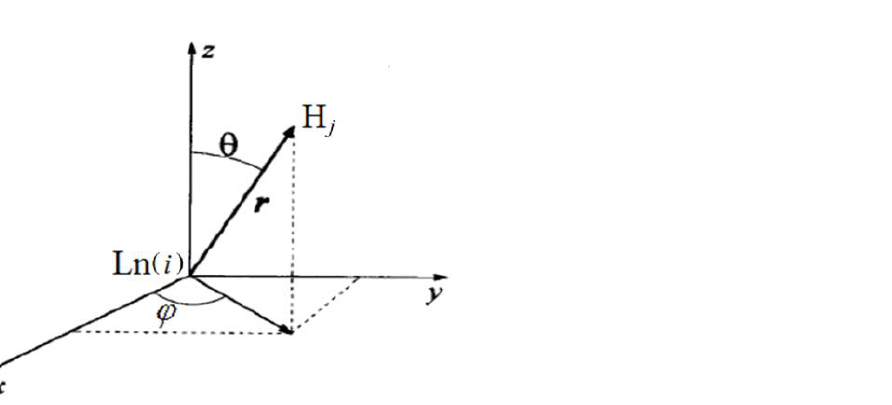
Figure 6. Spherical coordinates r , θ , ϕ of the nucleus of the hydrogen atom H j relative to the cation Ln, given in Formula (1).